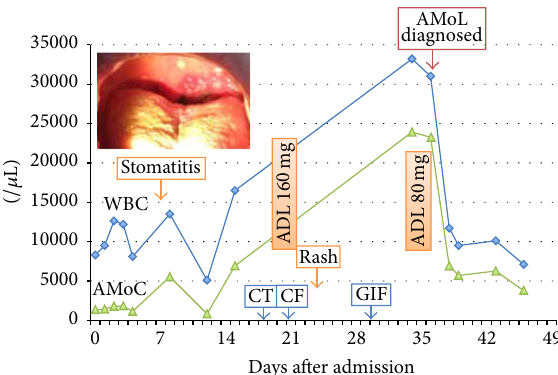
Figure 1: Clinical course of the patient: the patient first developed aphthous stomatitis (inserted photo), followed by intestinal BD-like lesions detected by CF and then skin rash. Significant monocytosis triggered by urinary tract infection was noted at the 5th week of admission and the eventual diagnosis of AMoL was made. WBC: white cell counts, AMoC: absolute monocyte counts, ADL: adalimumab, CT: computerized tomography, CF: colonofiberscopy, GIF = gastrointestinal fiberscopy.